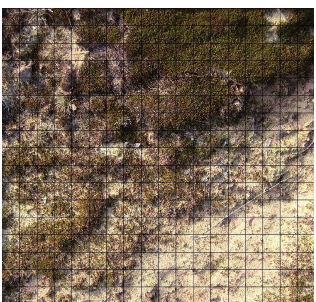
Figure 3. Example top view photo (1x1m) taken as a ground sample within the transects including overlaid GIS interpretation grid